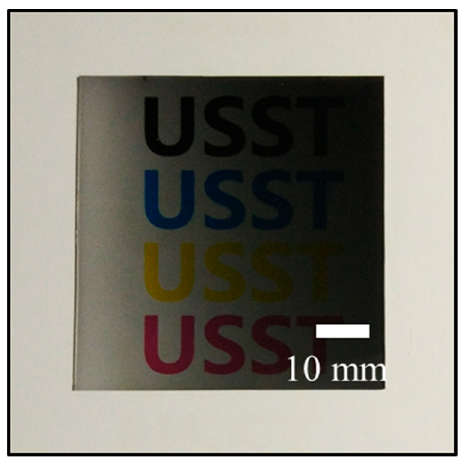
Figure 4. Cuneiform specimen (concentration c = 0.2 %; thickness, 0.3 mm < h < 2.0 mm), placed on top of paper with printed colored fonts.